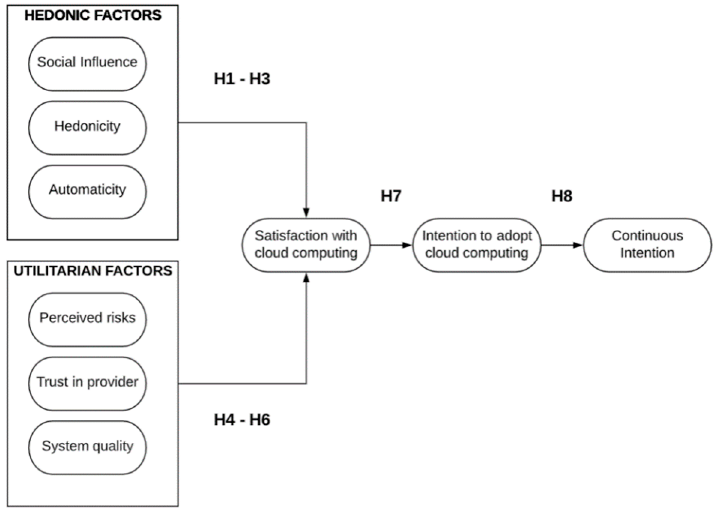
Figure 1. Research